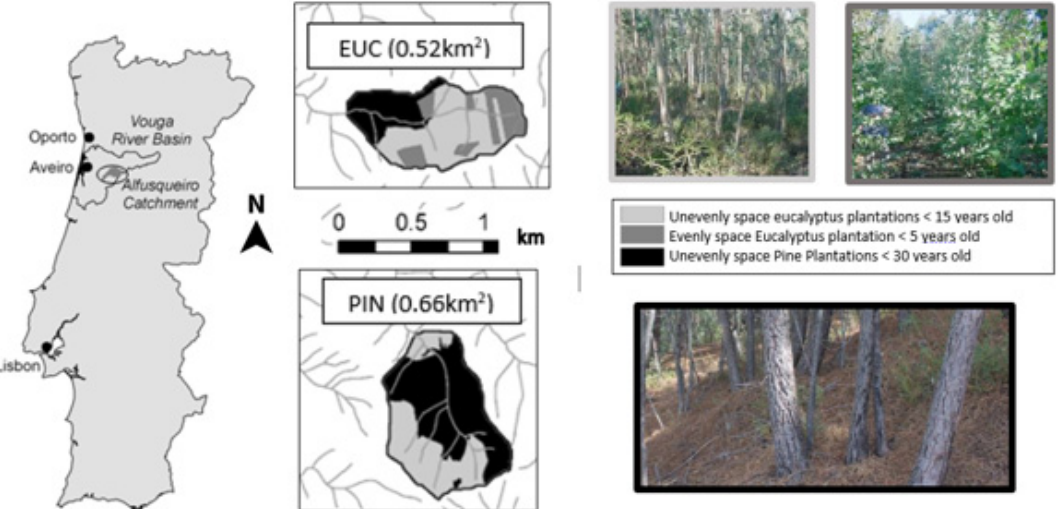
Figure 1. Location and land use of the two study catchments, Lourizela (PIN) and Serra de Cima (EUC), in North–Central Portugal.